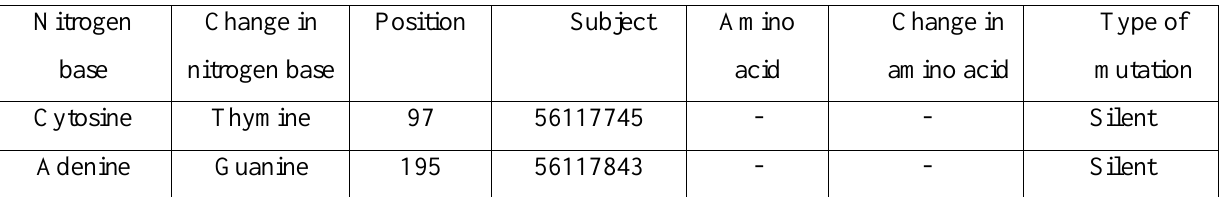
Table (3): Changes in Nitrogenous Bases and Their Effect on Translating Amino Acid of the QacE gene for Ps-4 Isolate of P. aeruginosa .